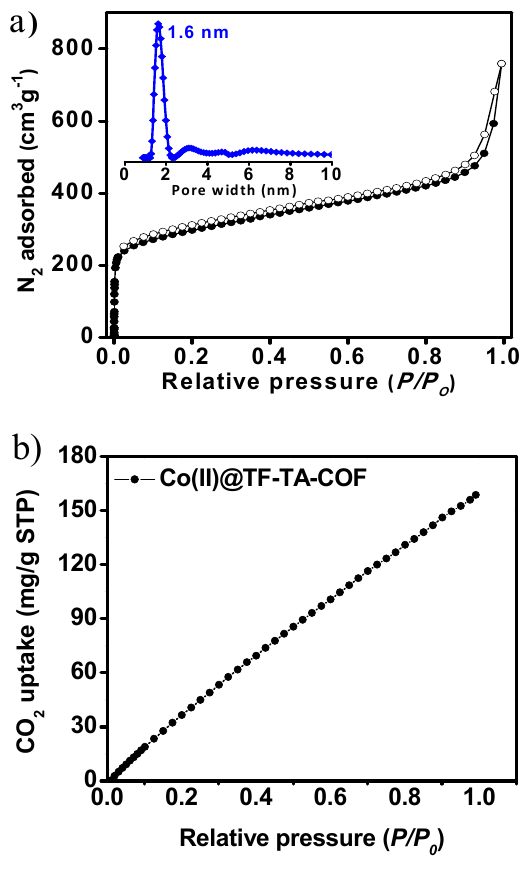
Figure 2. ( a ) Nitrogen sorption curves of Co(II)@TA-TF COF at 77 K (filled circles for adsorption, open circles for desorption). Insert: the pore size distribution of Co(II)@TA-TF COF and ( b ) CO 2 uptake ability of the Co(II)@TA-TF COF at 298 K.